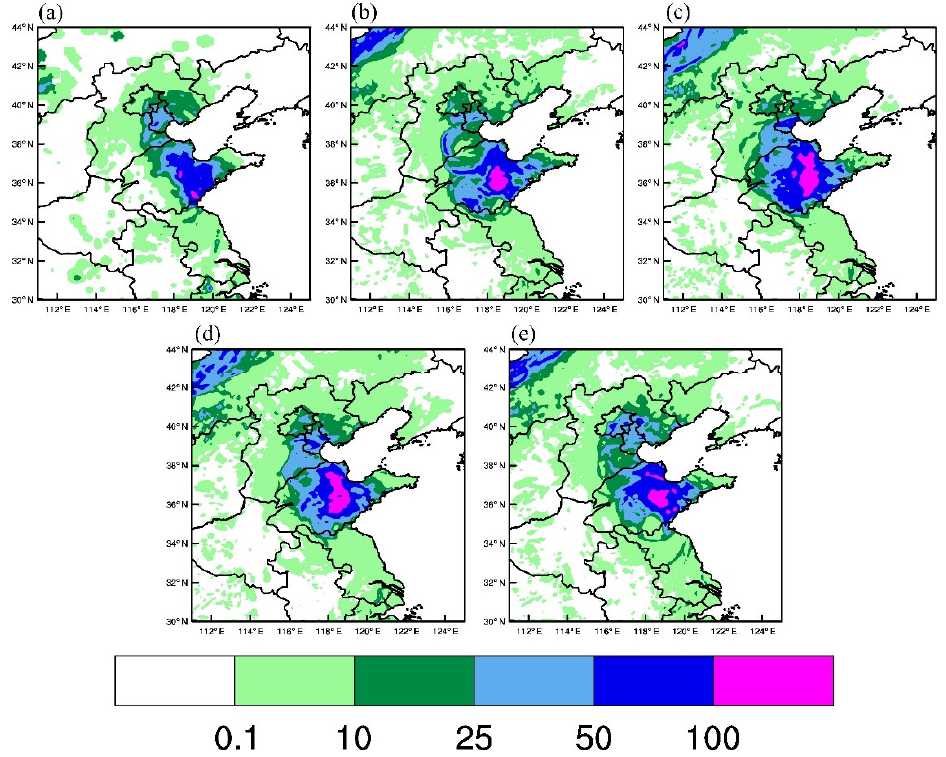
Figure 8. Accumulated 24-h rainfall (mm) from 0000 UTC on 23 July to 0000 UTC on 24 July 2018, ( a ) observation, ( b ) AMSU experiment, ( c ) MHS experiment, ( d ) MWHS experiment, ( e ) ALL experiment.